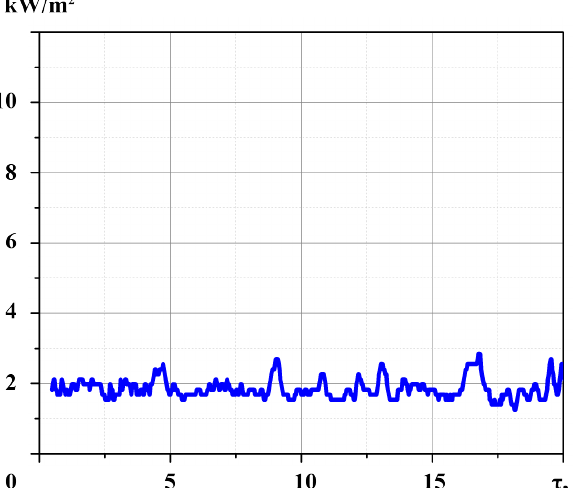
Figure 5. Time-dependent heat flux graph by GHFS for the regime without cooling (at the ˙ G w =